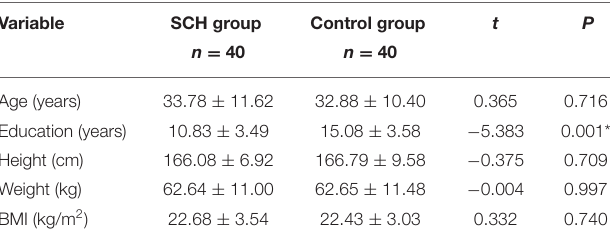
TABLE 1 | Participants’ ages, education levels, heights, weights, and BMIs (mean ± SD).